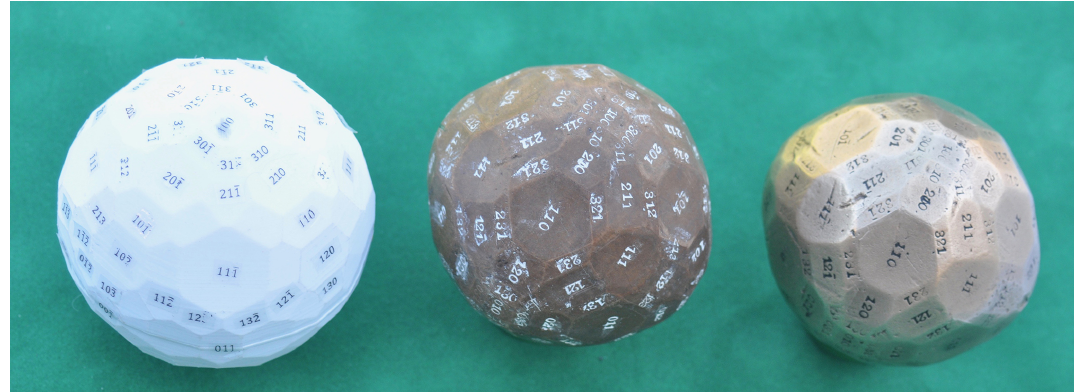
Figure 11. The three models: digital 3D copy (diameter 65mm), original model 416 and bronze copy (65mm only between two ( 001 ) opposite